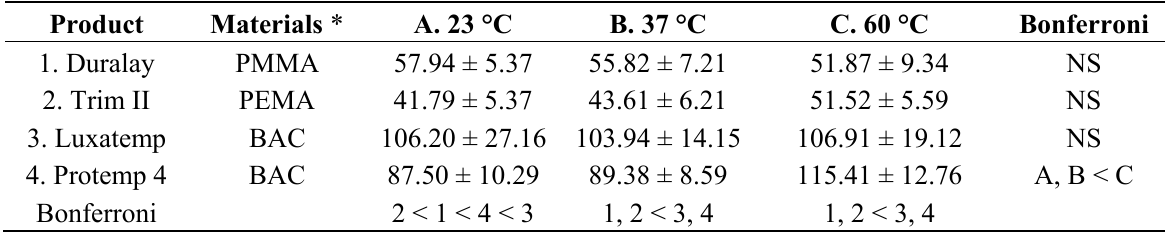
Table 2. No significant difference of flexural strength was found in Duralay (PMMA), Trim II (PEMA) and Luxatemp (bis-acrylic composite) specimens at the three curing temperatures. The flexural strength of Protemp 4 (bis-acrylic composite) increased when cured at 60 °C. Luxatemp and Protemp 4 showed significantly higher values than Duralay and Trim II at the three curing temperatures. Table 2. Flexural strength (MPa) (±SD) of the materials and curing temperatures.